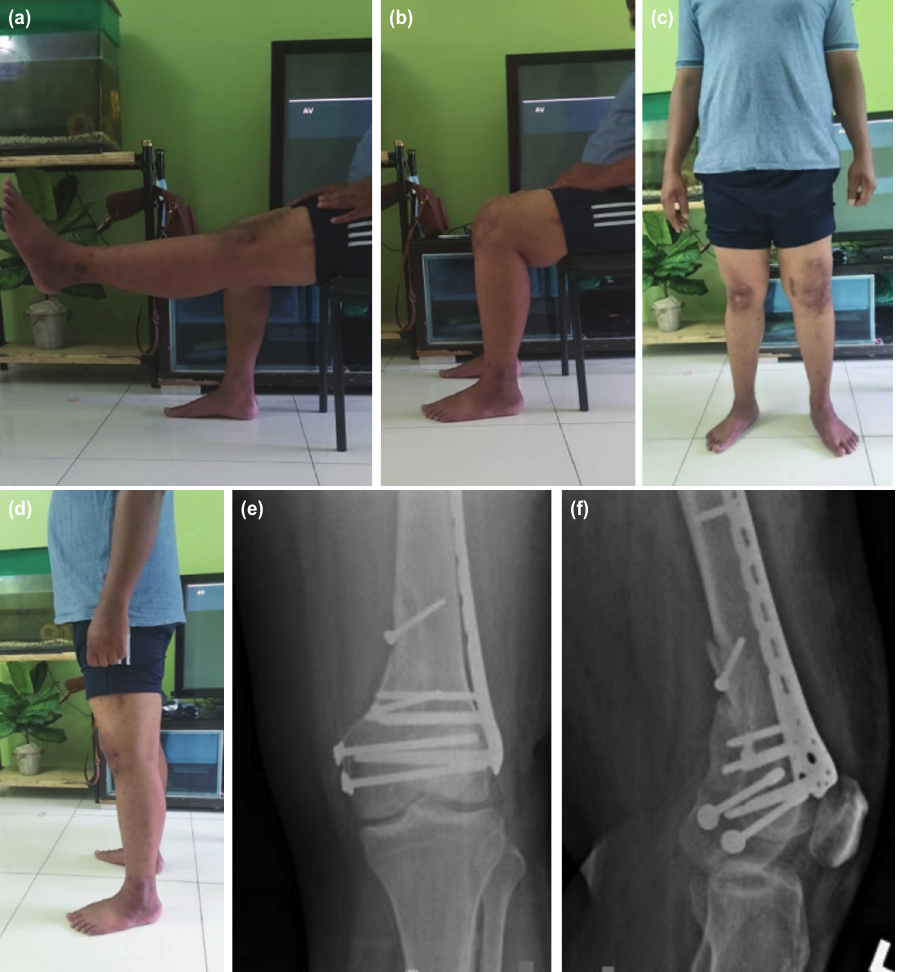
(a, b) Clinical picture showed the patient was able to flex full extension and his left knee up to 90°, (c, d) the patient was able Fig. 3: to stand without any aids, (e, f) post-operative radiograph AP and lateral view over left distal femur showed fracture have